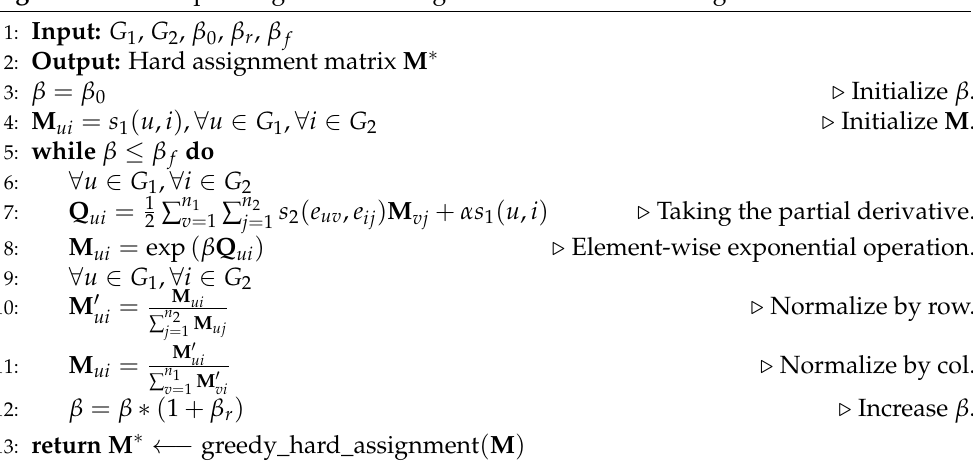
Algorithm A1 Simplified graduated assignment for ARG